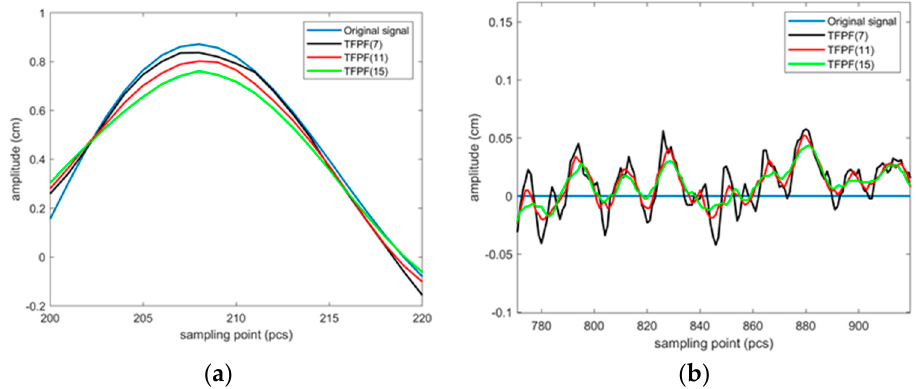
Figure 2. Local enlarged view of sampling point ( a ) 200~220 and ( b ) 770~920.